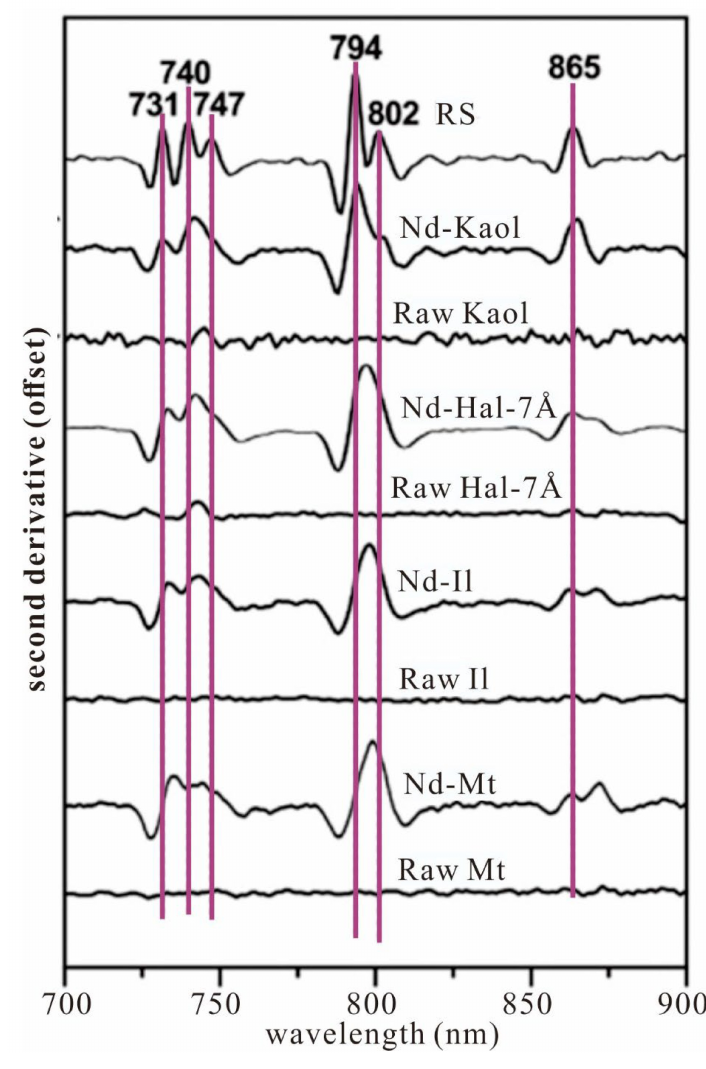
Figure 5. Secondary derivative reflectance spectra in the range of 700–900 nm (modified from [42]). RS—sample from the Renju REE deposit with a total REE concentration of 3340 ppm;